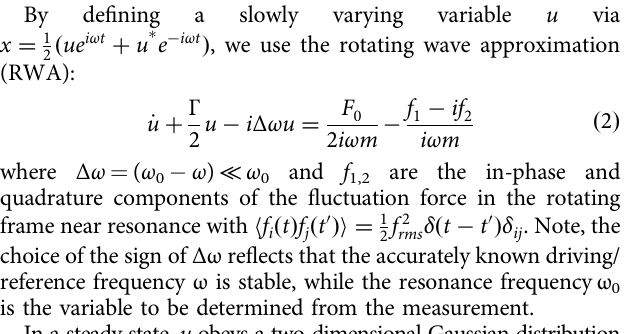
applied to the tuning fork from a sharp metal probe positioned in proximity to the fork. The mechanical motion of the tuning fork is measured through a near- fi eld cavity-optomechanical readout (See Supplementary Note 1) 29 with detection noise well below the thermal fl uctuation within the fork resonance linewidth.